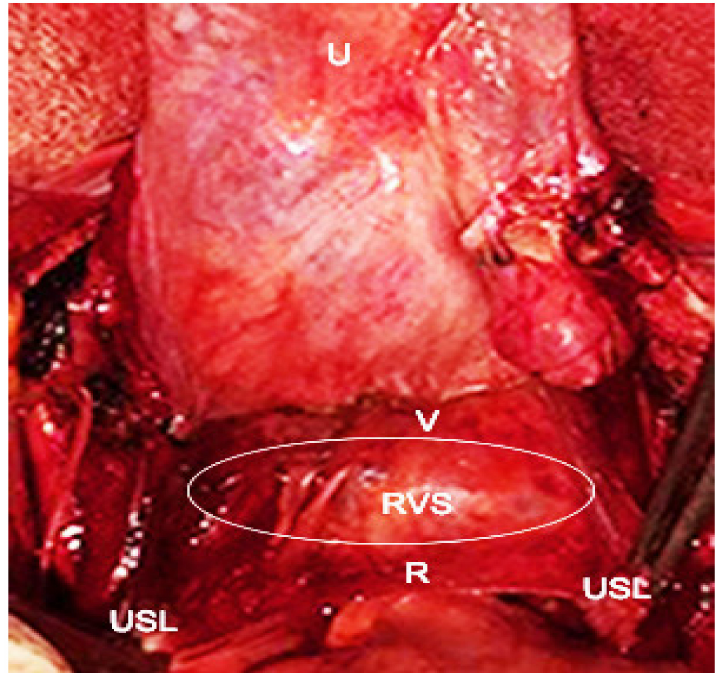
Figure 13. Rectovaginal space. U–uterus; USL–uterosacral ligaments are cut and pick up with tweezers; R–anterior rectal wall; V–posterior vaginal wall; RVS–rectovaginal space. This area is also recognized as the posterior cul-de-sac [17]. There are two di ff erent approaches to the rectovaginal space (RVS)—medial and lateral. Through the medial approach, the rectouterine pouch is cut and the Denonvilliers’ fascia is exposed. Denonvilliers’ fascia is more prominent in younger patients and corresponds to rectovaginal septum in